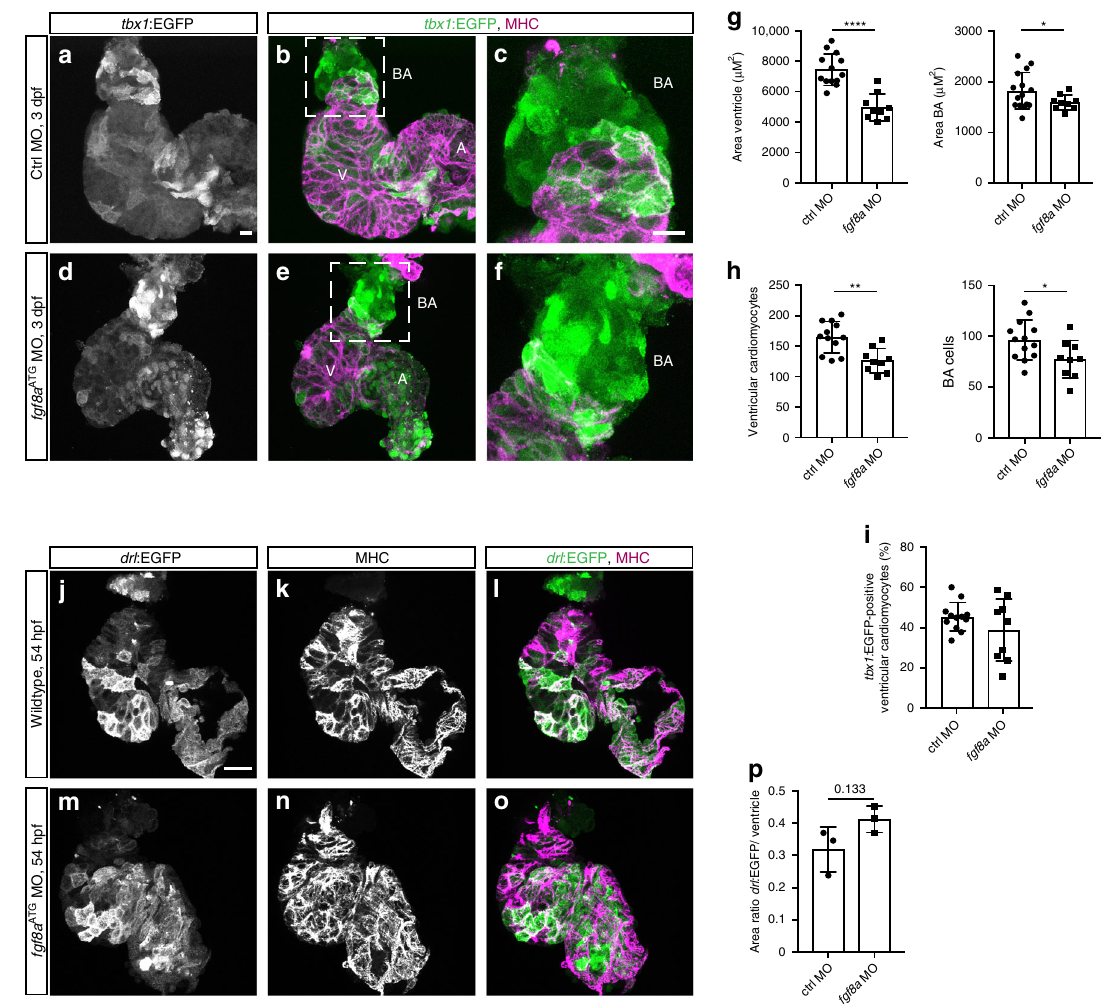
Fig. 6 fgf8a knockdown leads to perturbed ventricle and BA formation. a – f Top-down 7- μ m confocal section of wild-type control ( a – c ) and fgf8a ATG morphant ( d – f ) hearts at 3 dpf. tbx1 :EGFP, counterstained with anti-GFP labels the bulbus arteriosus (BA) and scattered ventricular (V) and atrial